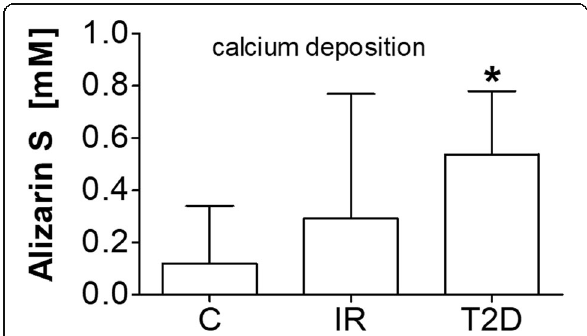
Fig. 6 Alizarin red S concentration [mM] in examined groups; insulin-resistance (IR), type 2 diabetes (T2D) compared to control cells (C); ANOVA with the Tukey post hoc test * p < 0.05 vs.